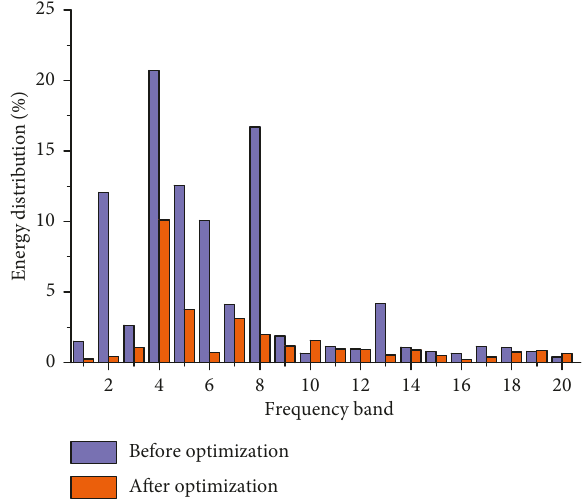
Figure 22: Energy percentage with frequency band distribution.